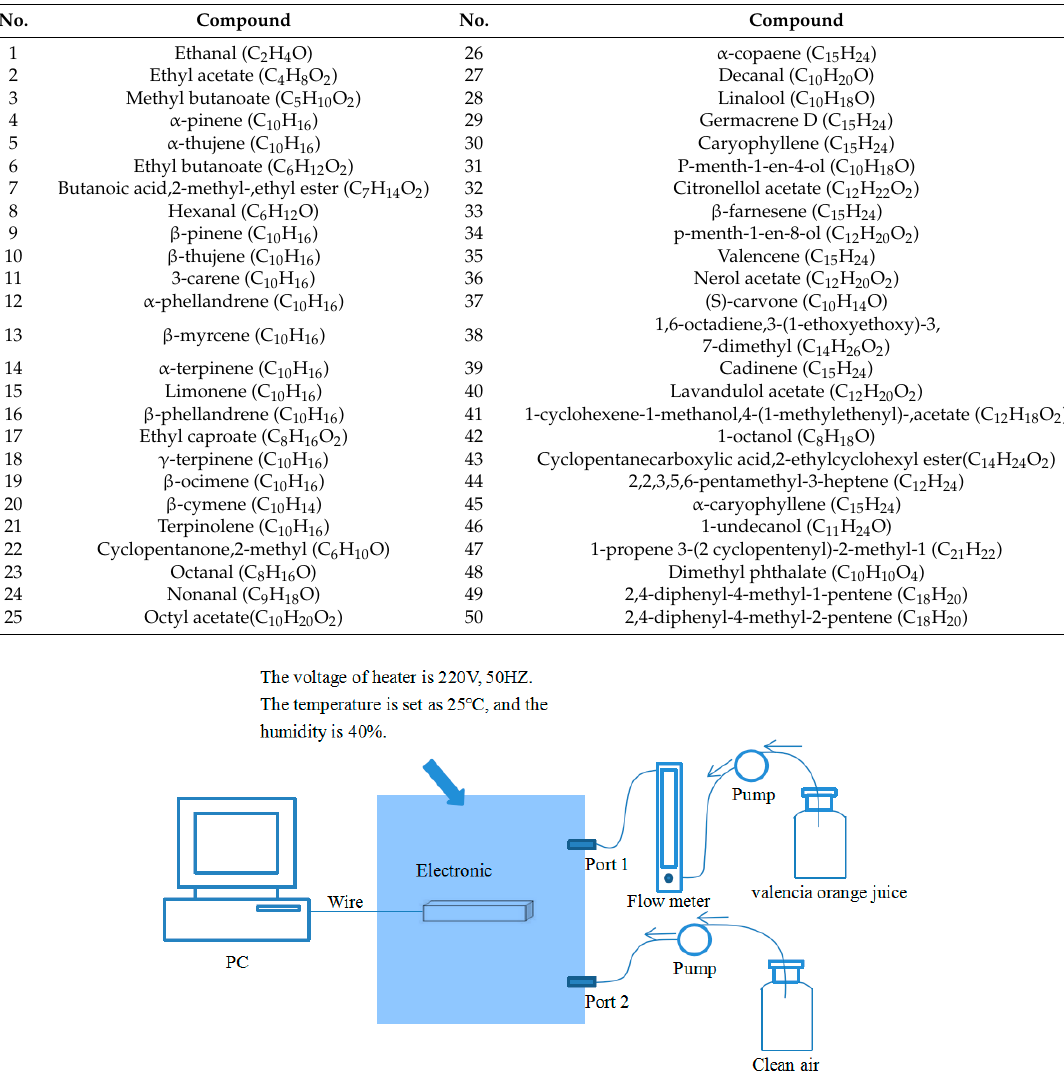
Table 1. The analysis of orange juice aroma components.